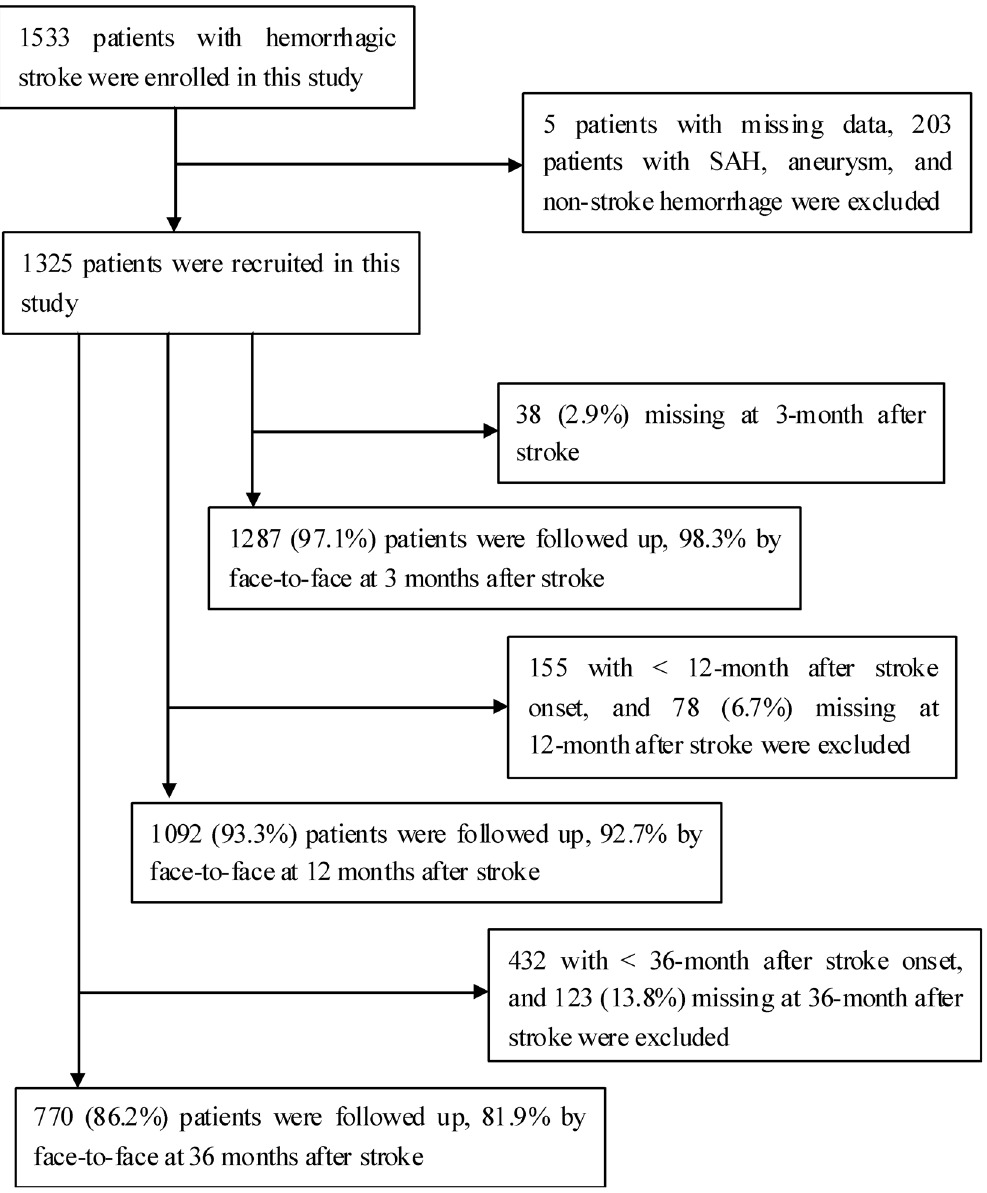
Figure 1. Response rates were 97.1% at 3 months after ICH, 92.9% at 12 months after ICH, and 86.2% at 36 months after ICH, respectively. ICH, intracerebral